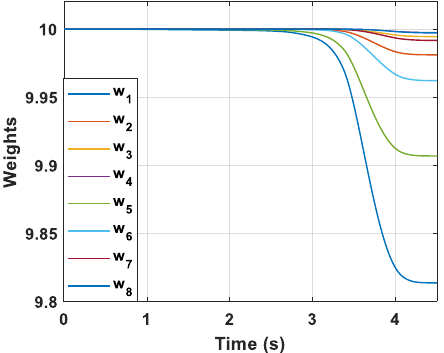
Figure 5. Convergence curves of critic NN weights.